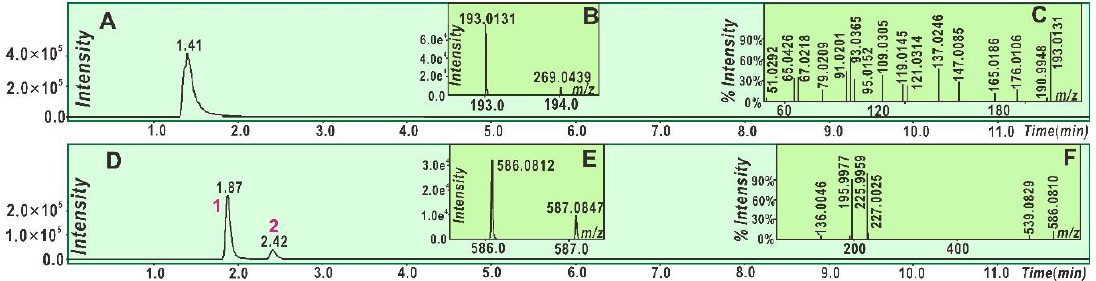
Figure 5. Main results of 3,5,7-trihydroxychromone in the UPLC-ESI-Q-TOF-MS/MS analysis: ( A ) Total ion chromatographic diagram of 3,5,7-trihydroxychromone; ( B ) primary MS spectra of 3,5,7-trihydroxychromone; ( C ) MS/MS spectra of 3,5,7-trihydroxychromone; ( D ) total ion chromatographic diagram of 3,5,7-trihydroxychromone-DPPH adduct; ( E ) primary MS spectra of 3,5,7-trihydroxychromone-DPPH • ; and ( F ) MS/MS spectra of 3,5,7-trihydroxychromone-DPPH adduct.